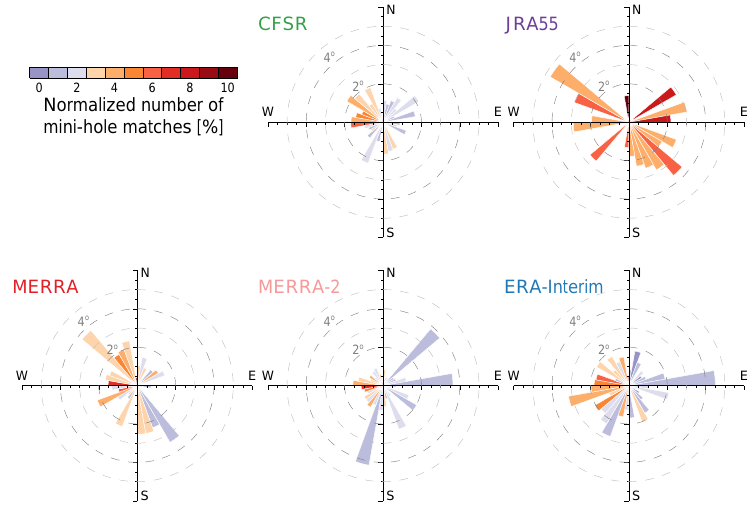
Figure 7. Wind rose plots showing the direction in which events found in the reanalysis fields would have to move to match the events found in OMI data, as well as the mean angular distance to be moved in a particular direction. Gray dashed circles show angular distance. Red/blue indicate relatively high/low normalized number of matches.